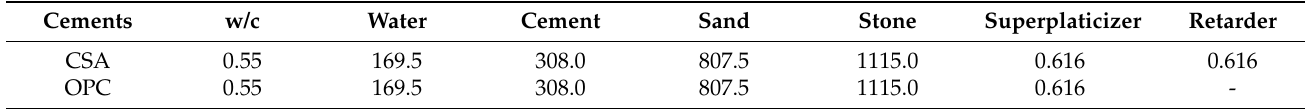
Table 2. Mix formulation to prepare CSA and OPC concretes (Unit: kg/m 3